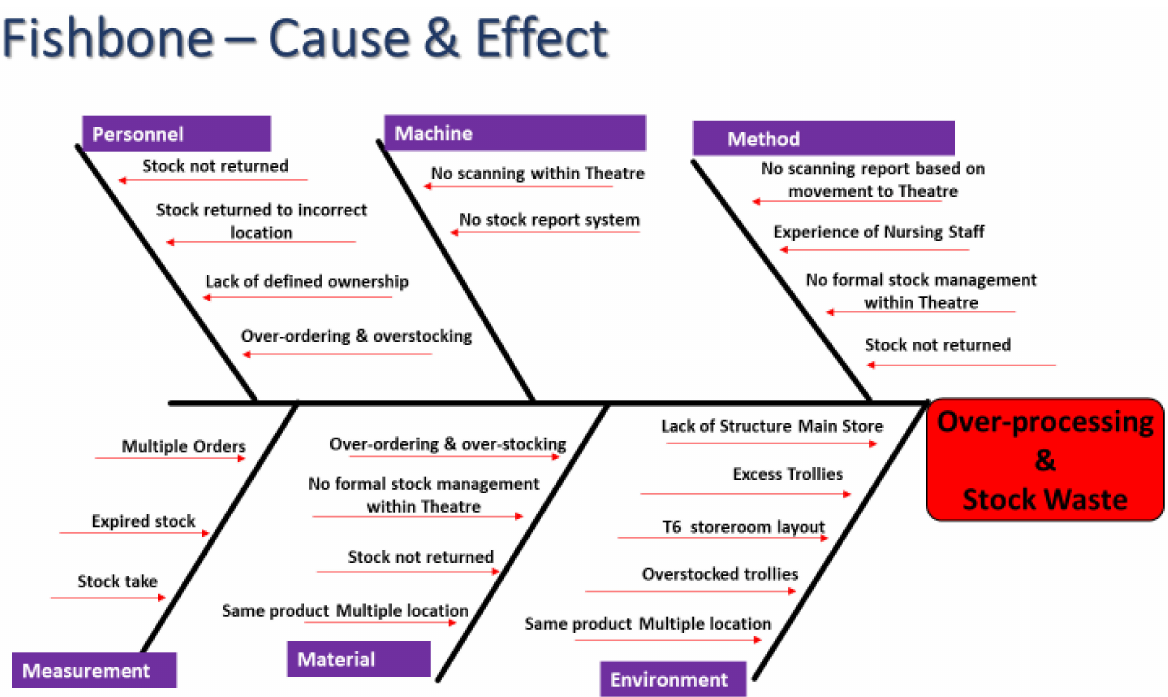
Figure 4. Fishbone for OR Stock